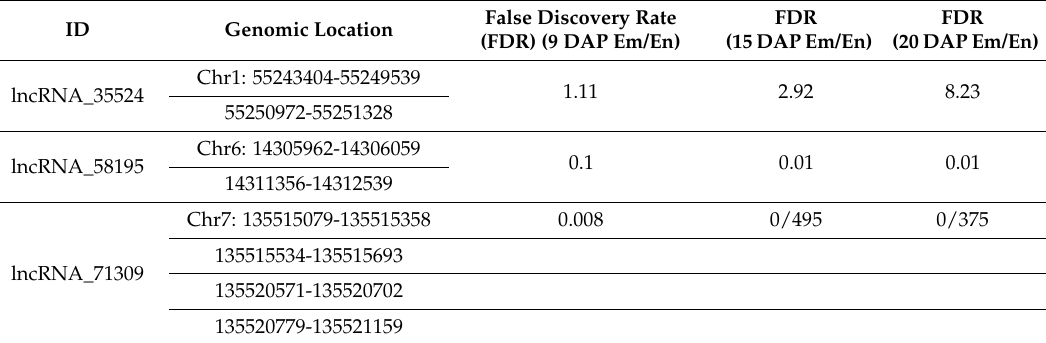
Figure 6. Validation of the expression profiles of seven lncRNAs, GRMZM2G79290 and miR159j ‐ 5p in endosperm at 9 DAP, 15 DAP, and 20 DAP. To validate the seven lncRNAs can potentially regulate mRNA as ceRNA trough miRNA, GRMZM2G79290, and miR159j ‐ 5p were selected to perform qPCR to test the expressions of lncRNA deregulated mRNA. Blue bars stand for lncRNAs, red bars and dark blue bars stand for mRNA and miRNA, respectivelly. The relative expression of the seven lncRNAs and one mRNA normalized to ACTIN. The relative expression of miRNA normalized to U6. Table 2. Detailed information of seven lncRNAs with ceRNA activity during the seed development.